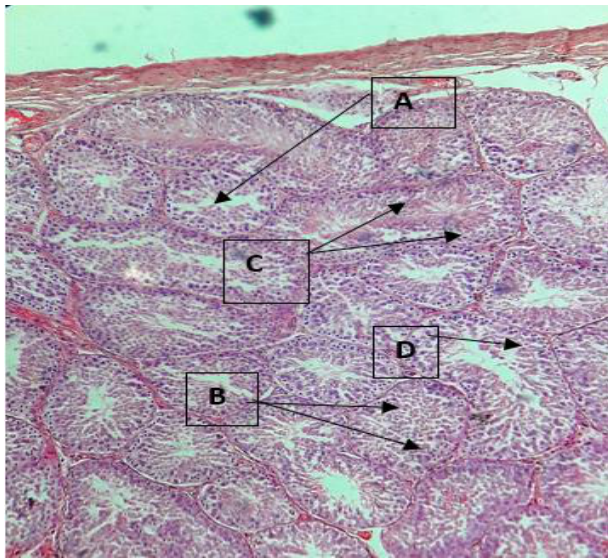
Fig. 1.4. Photomicrograph of testes showing tunica albuginea (A), Fig. 1 .5. Photomicrograph showing spermatogenic cells in stratifie seminiferous tubules (B) and interstitial tissue (C)(Control group layers (A), Leydig cells (B),spermatids (C) and spermatogonia 100X. (D)(Controlgroup 400